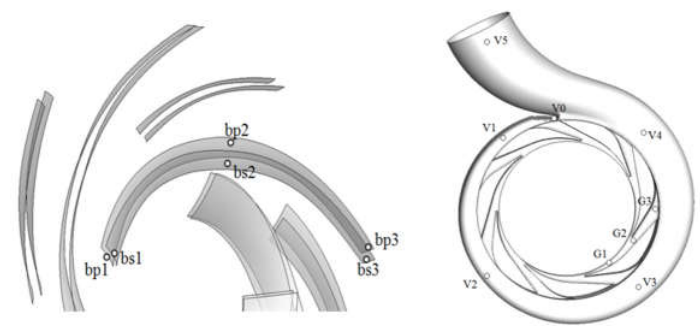
Figure 13. Location of the monitoring points in the flow domain.